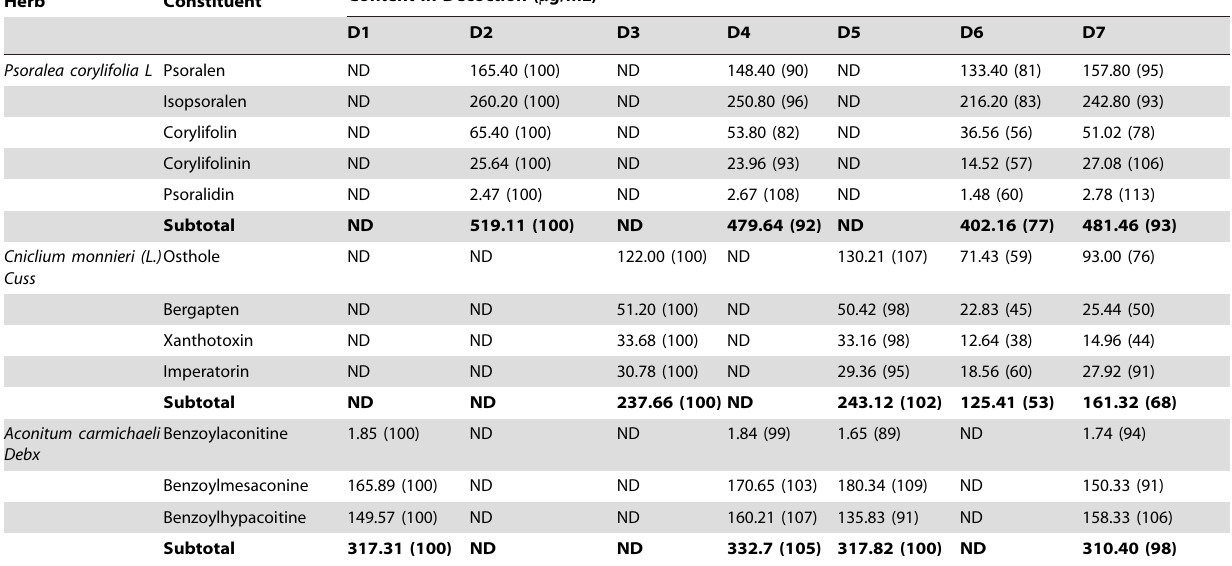
Table 2. Contents of 15 constituents in 7 decoctions.